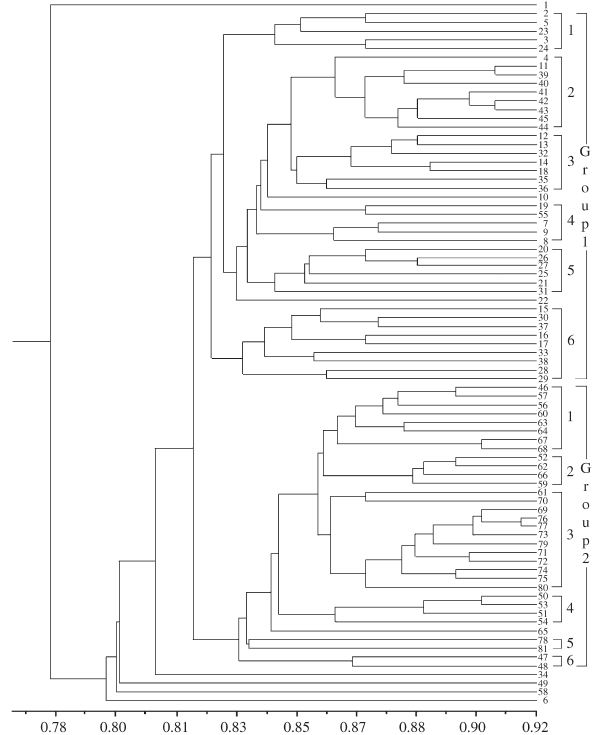
Figure 4 - Dendrogram of 81 maize accessions constructed using UPGMA method based on a similarity matrix produced with simple matching coefficients. Numbers 1 through 81 refer to the collection listed in Table